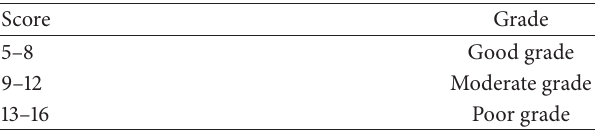
Table 2: Bryne et al. grading system (Bryne et al., 1989)